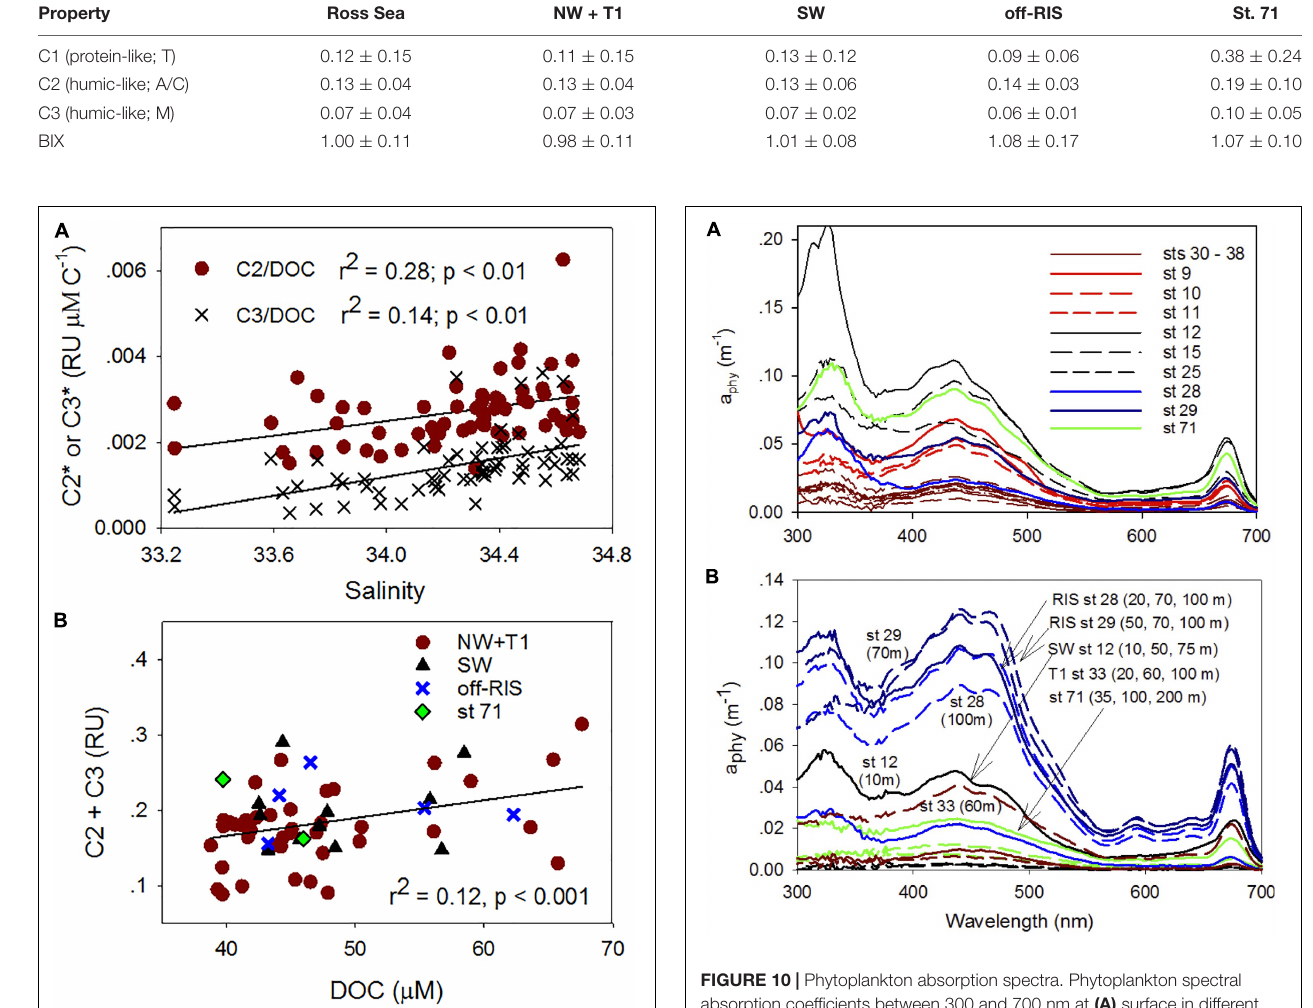
FIGURE 10 | Phytoplankton absorption spectra. Phytoplankton spectral absorption coefficients between 300 and 700 nm at (A) surface in different regions of the shelf (NW + T1 – brown, SW – black, and off-RIS – blue) and (B) at different depths for typical stations in the SW (st 12), transect T1 (st 33), off-RIS (sts 28 and 29) and station